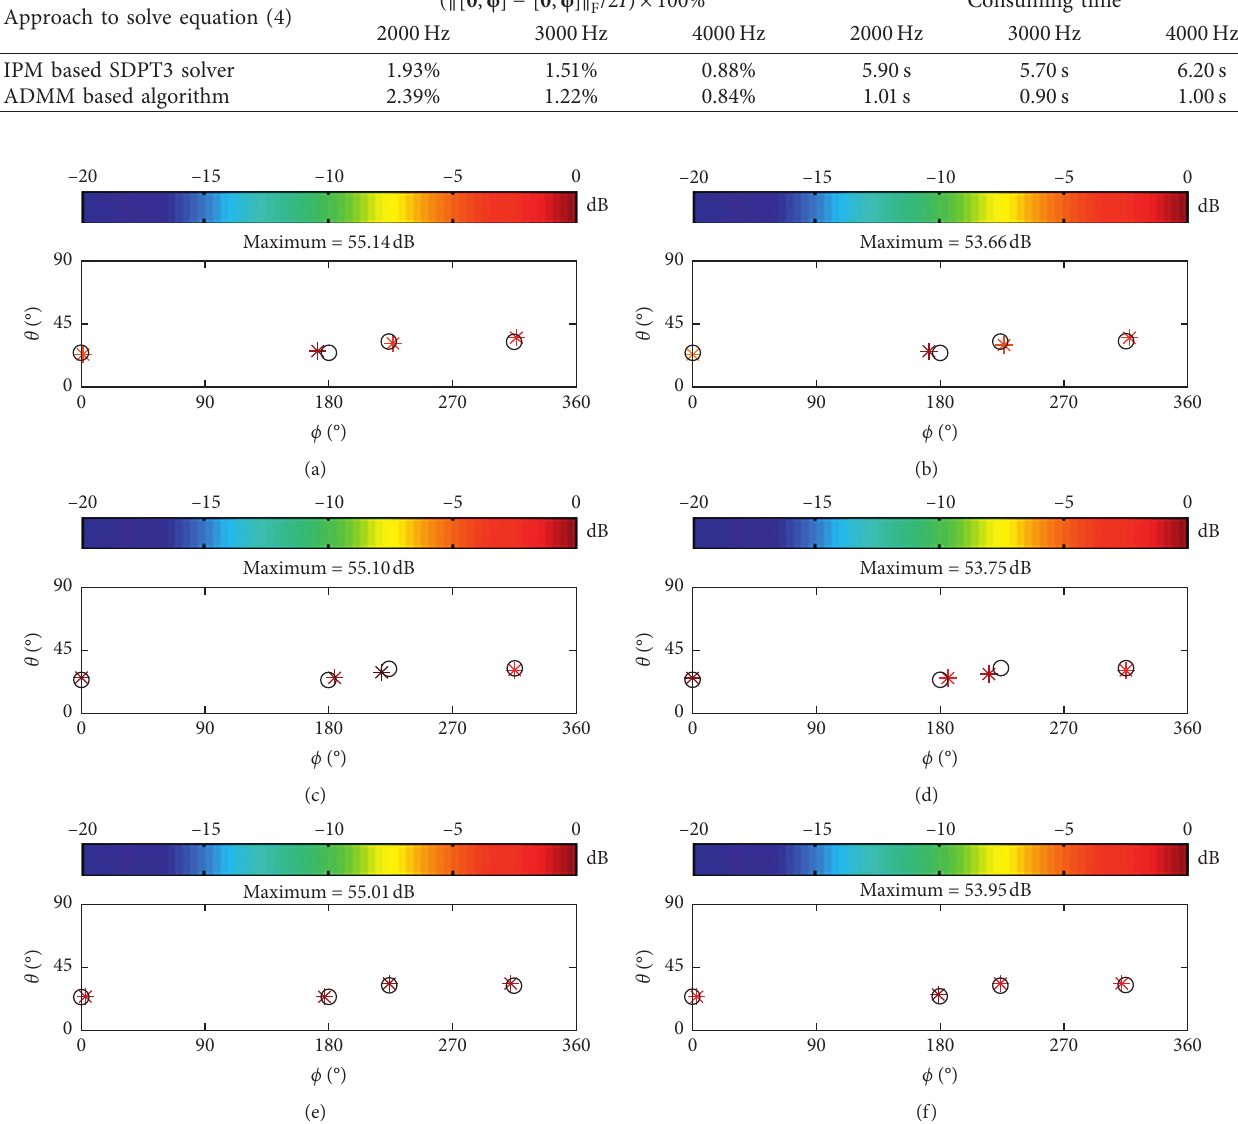
Table 1: DOA estimation error corresponding to Figure 5 and consuming time of IPM based SDPT3 solver and ADMM based algorithm. Approach to solve equation